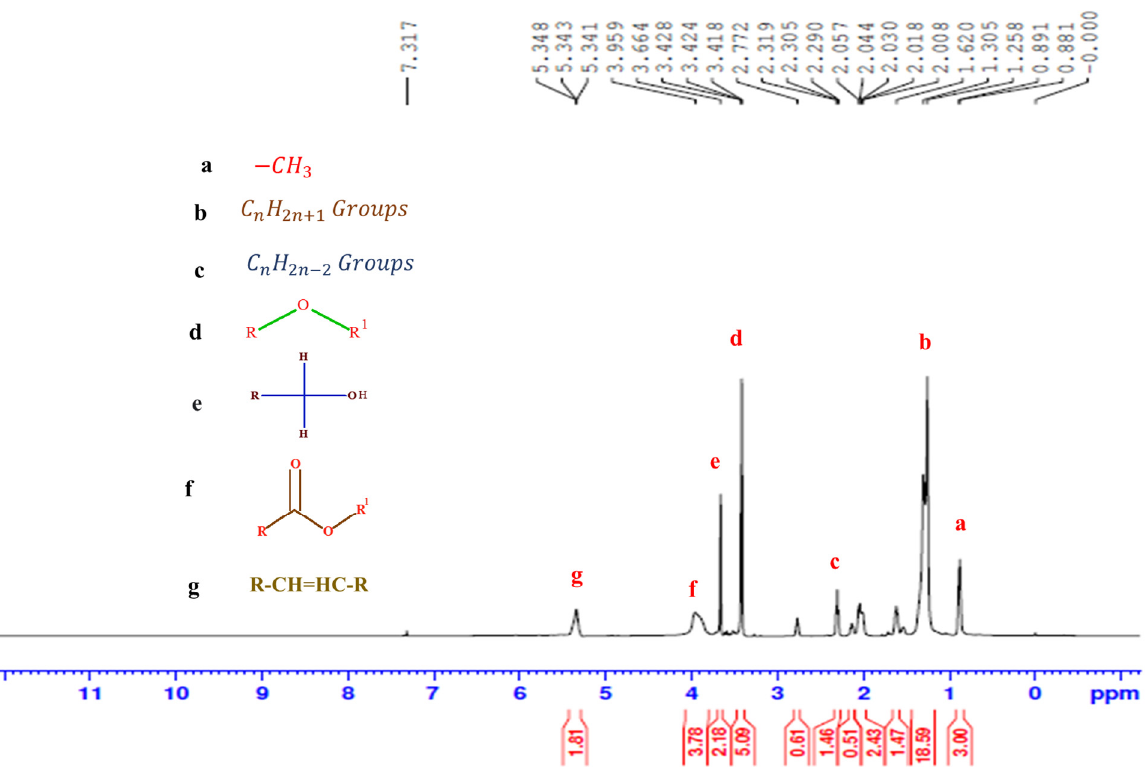
Figure 6. H-NMR spectrum of Kapok biodiesel to analyze the carbon chain.